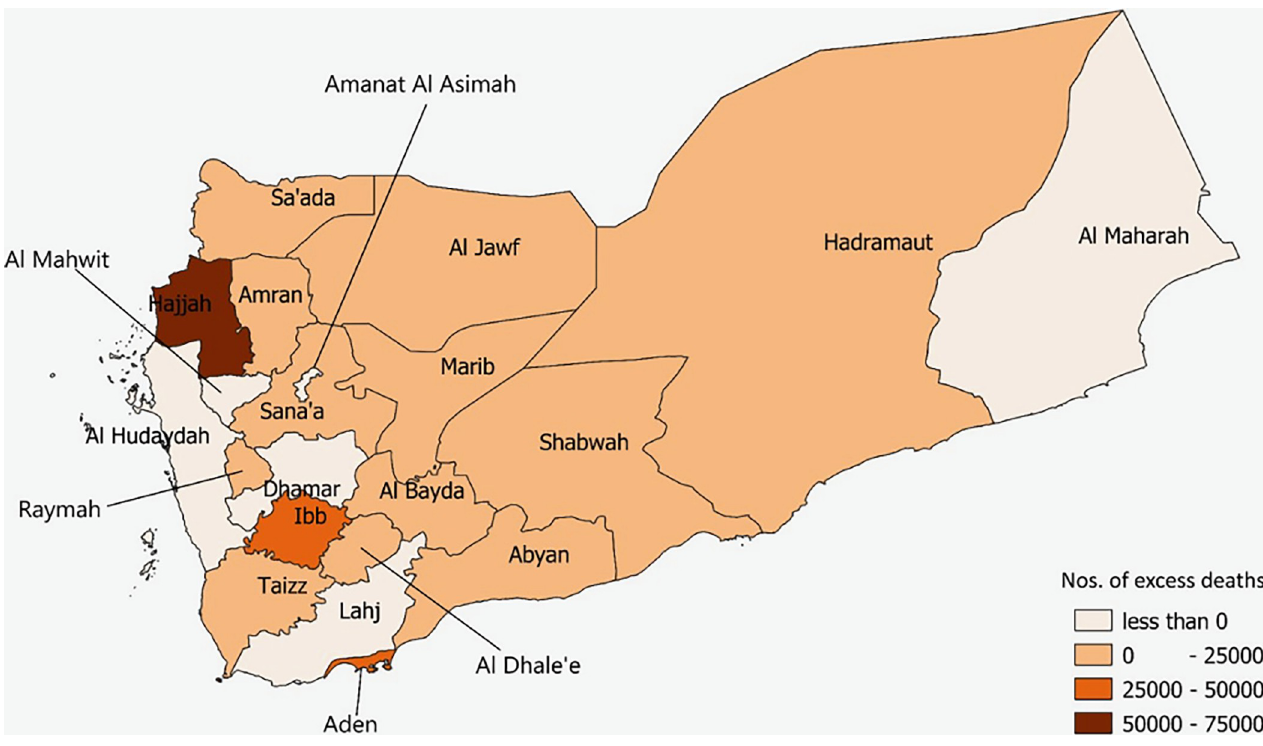
Fig 3. Geographic distribution of insecurity index levels, Yemen, 2015–2019.